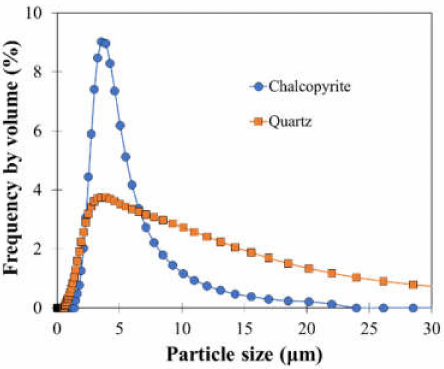
Figure 1. Particle size distribution of the crushed chalcopyrite and